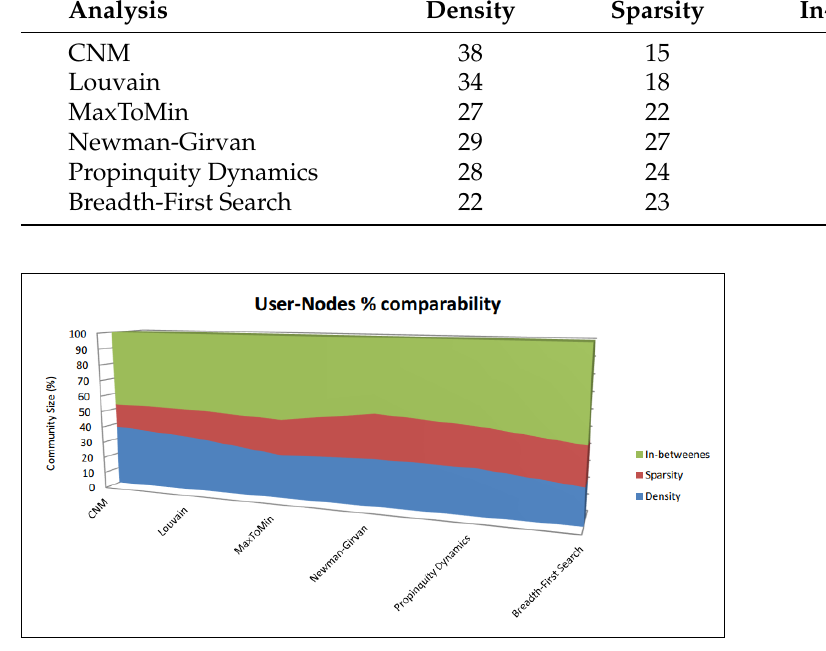
Figure 5. Graphical depiction of communities % with comparable